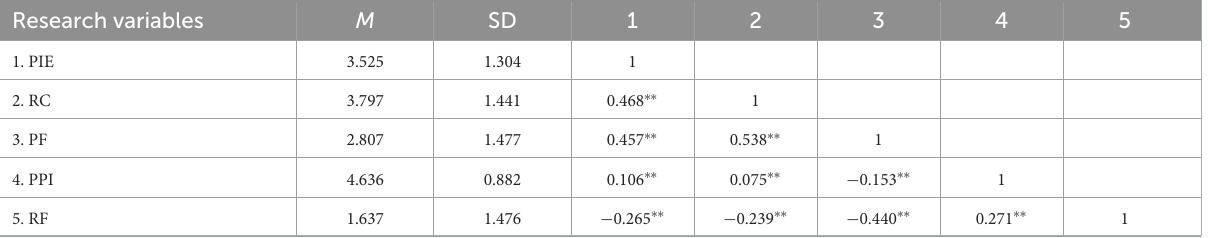
TABLE 3 Means, standard deviations, and correlations among research variables. Research